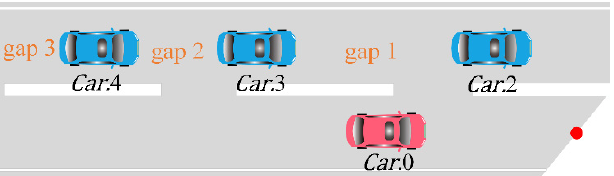
Figure 5. MLC scenario. Table 4. Lane-changing cut-in positions